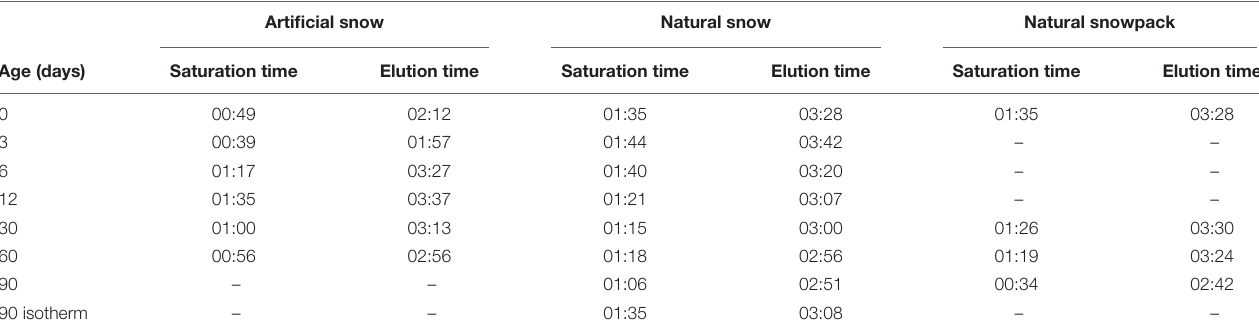
TABLE 3 | Saturation and Elution Time in